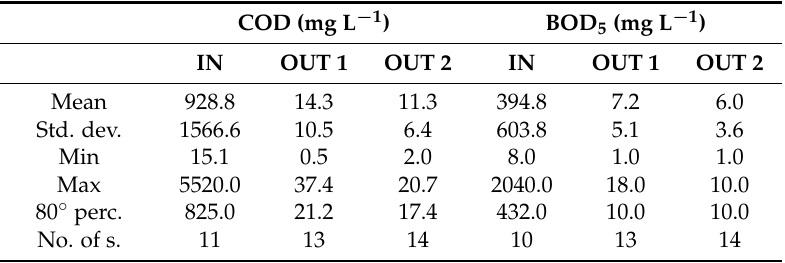
Figure 2. COD, BOD 5 , TN, N-NH 4+ , TP, and TSS concentrations of treated wastewater effluent from the FRB WWTP of Castelluccio di Norcia from the 18 February 2014 to the 18 October 2016, compared with the set targets for effluent water quality. IN: influent to first FRB beds. OUT 1 and OUT 2: effluent from the two FWS beds. Table 3. Analysis of pollutant concentrations of wastewater treated by the FRB WWTP of Castelluccio di Norcia municipality. OUT 1 and OUT 2 refer to the effluent from the two FWS beds. Data from the 18 February 2014 to the 18 October 2016.